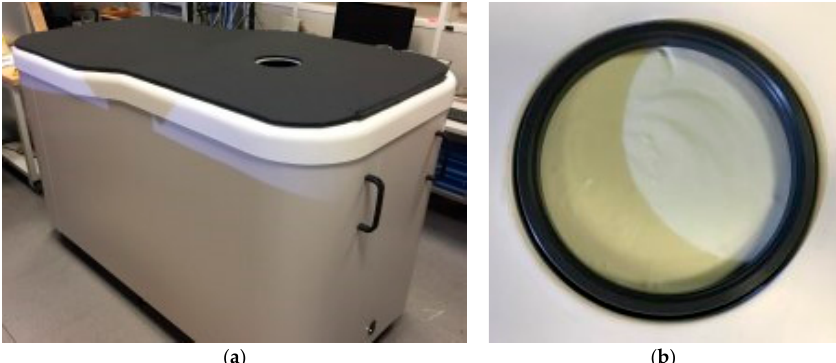
Figure 2. Wavelia microwave breast imaging system: ( a ) Top view of the examination table; ( b ) Zoomed view on the transition liquid in which the breast is immersed during the scan.